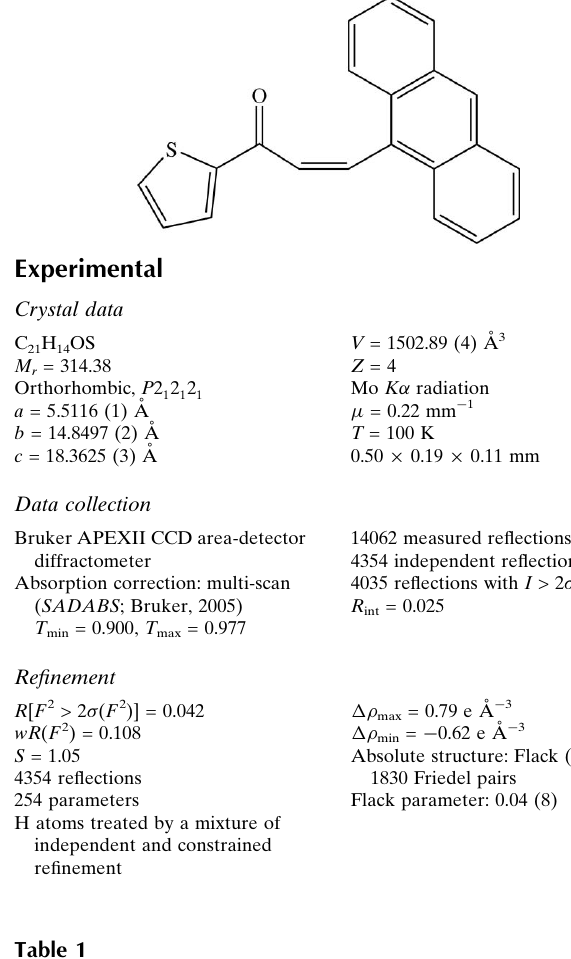
Hydrogen-bond geometry (A˚ , (cid:5)